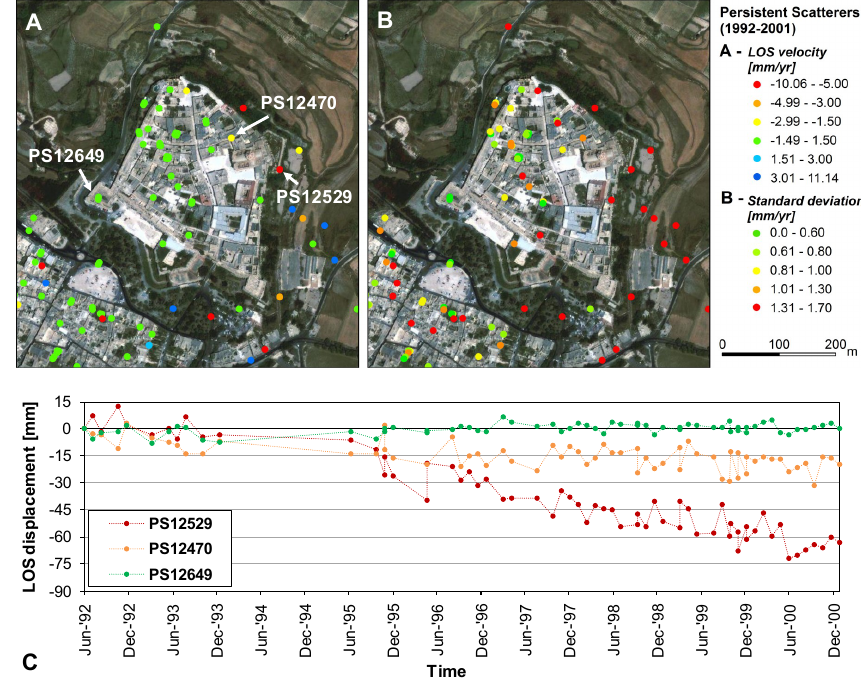
Fig. 16. (A) : LOS displacement velocities measured between 1992–2001 for the ERS1/2 Persistent Scatterers identified in the area of Mdina. Negative velocities indicate movements away from the sensors, while positive values indicate movements toward the sensor. (B) Standard deviations of LOS velocity of the identified PS. (C) : Deformation time series of selected PS. For graphical purposes, the temporal reference for the time series was shifted from the master images (30 March 1998) to the first SAR acquisition (5 June 1992).